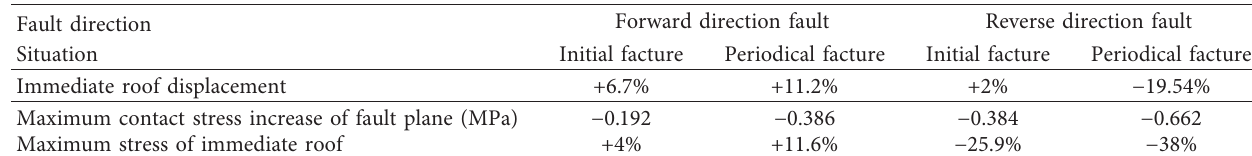
Figure 31: Analysis of calculation of reverse direction fault with periodical fracture. (a) Subsidence of the roof. (b) Vertical stress. Table 3: Influence of searching tunnel on roof and fault